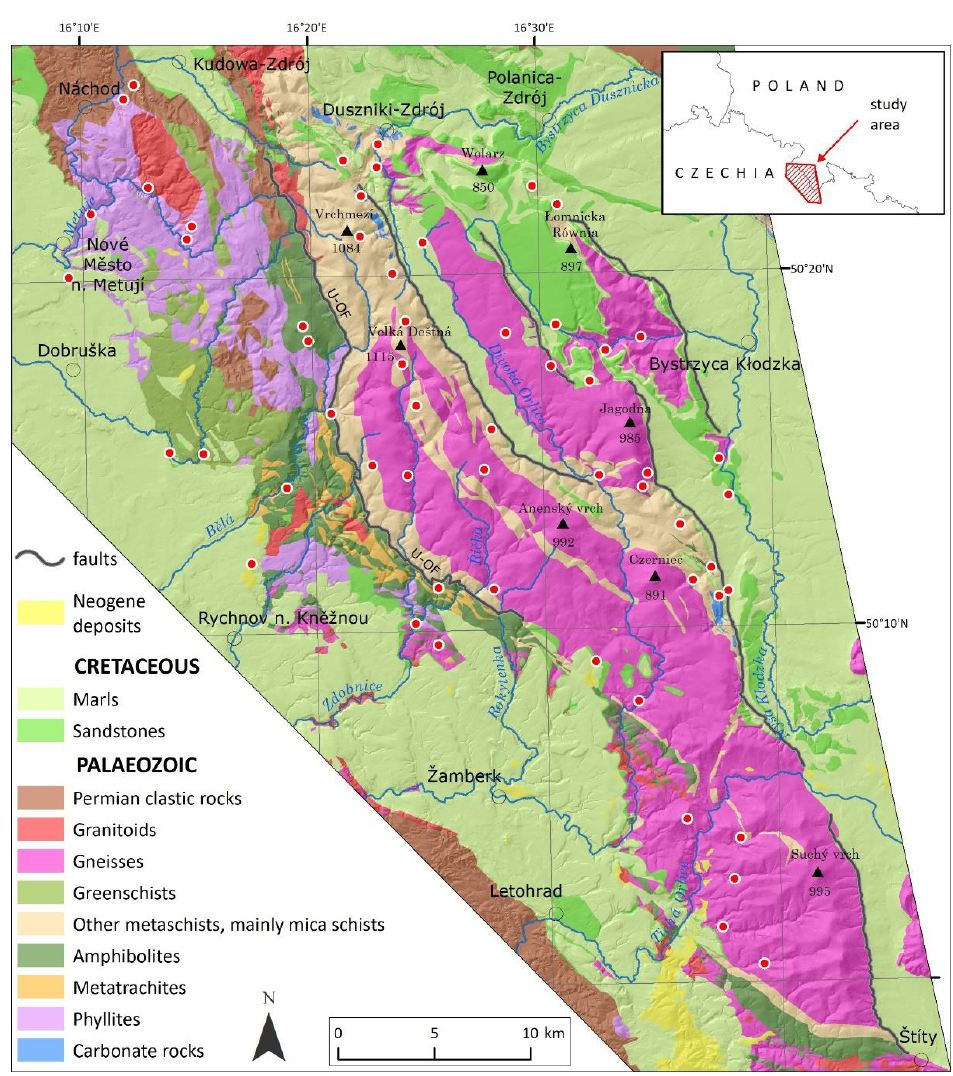
Figure 2. Geology of the Orlické–Bystrzyckie Mountains Block and location of geosites (see Figure 1 for specific geosite numbers). U-OF—Olešnice–Uhřinov Fault.